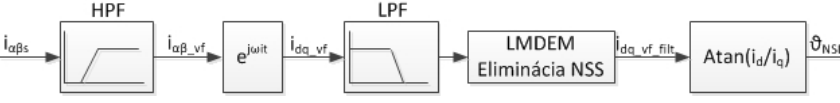
Figure 23. Position estimation and position estimation error after NSS filtering . 8. Different Modes—Starting, Reversing, Engine Load After eliminating the asymmetry that does not carry any information about the rotor position, the quality of the rotor position estimation can be verified in different drive modes such as start-up, reversal, back-reversal, and engine load. The drive again worked in scalar control mode. In the first interval from the left, the motor is at time t = 0.2 s on the ramp started up in 0.3 s with the stator voltage frequency of 5 Hz. As can be seen in Figure 24, the first course shows the course of the engine speed, followed by the course of the real and esti- mated rotor position, and the last course shows the estimation error, as well as the differ- ence between the real and estimated rotor position.